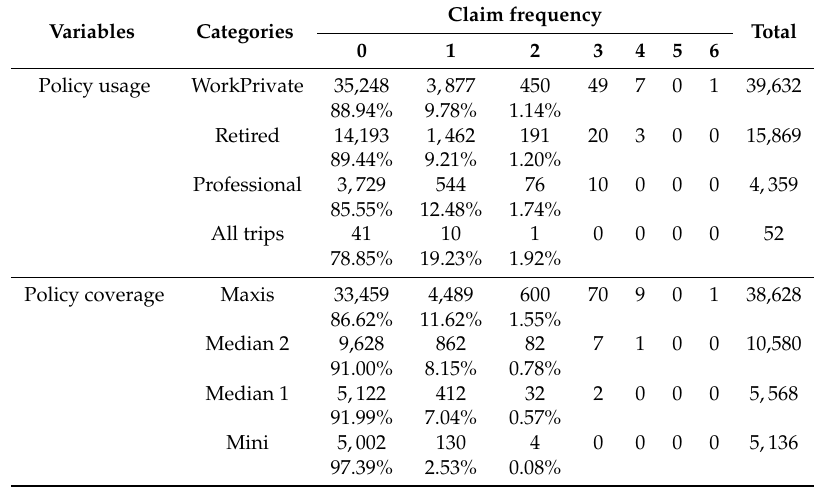
Table 3. Frequency of claims per categorical variables in the training